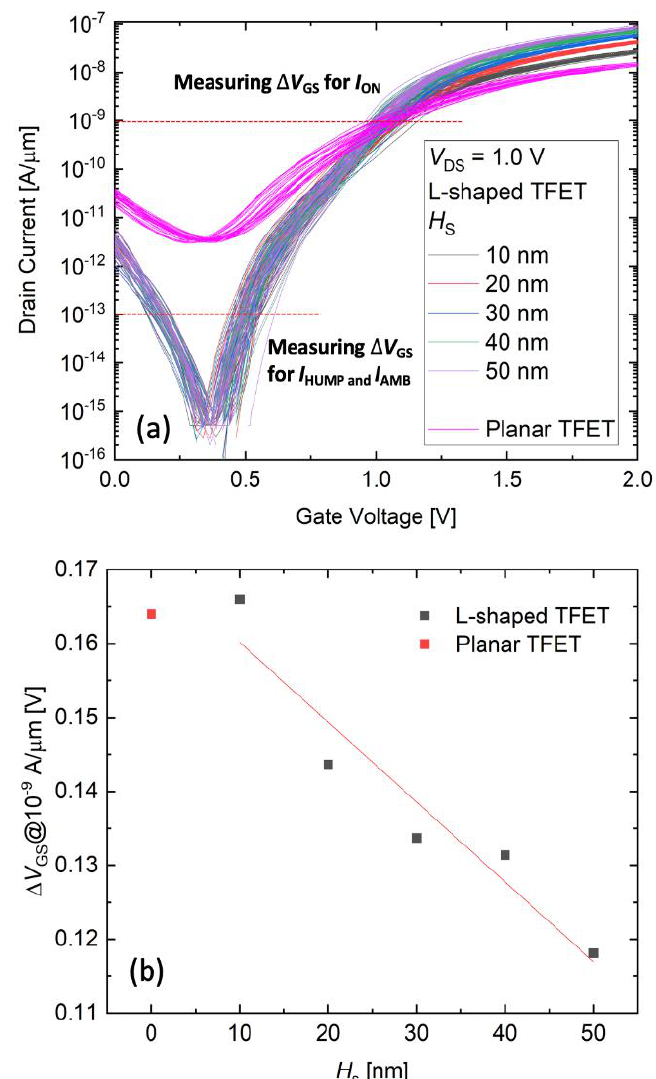
Figure 2. ( a ) Transfer curves of the L-shaped TFET. In each case of H S , 30 random samples for WFV are generated. ( b ) Dependency on H S and I ON variation.